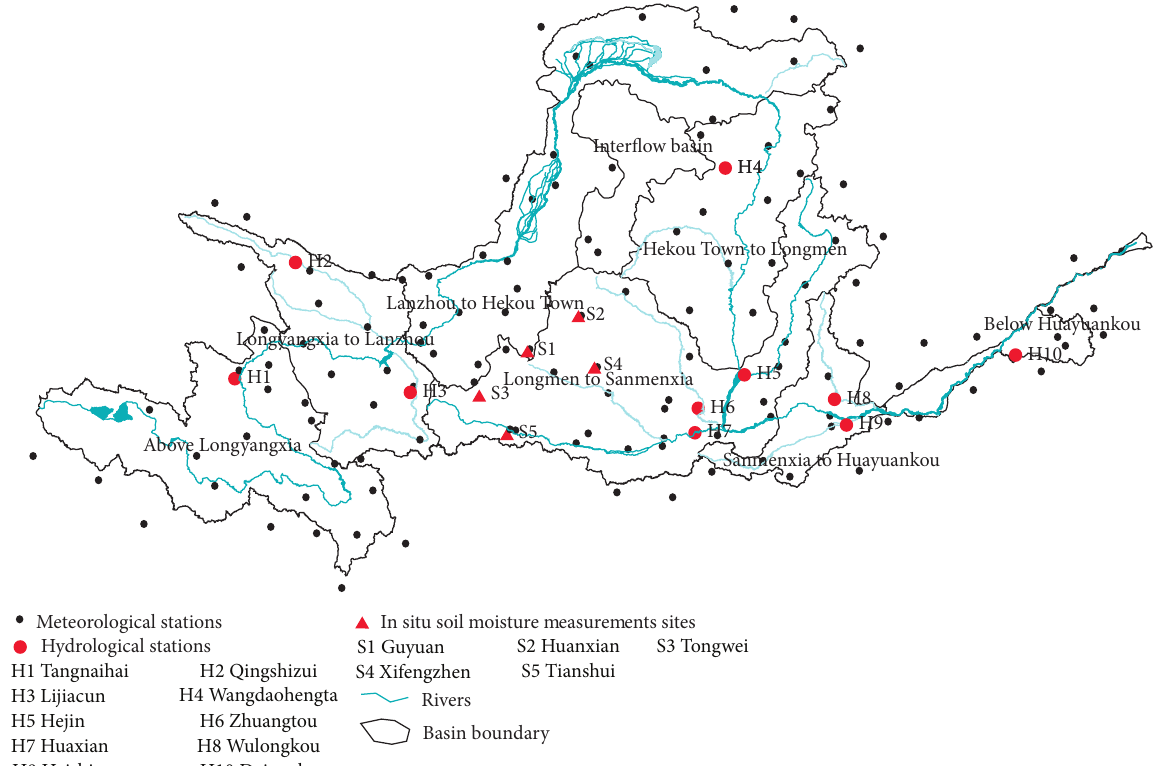
Figure 2: The geographic distribution of the 10 subbasins in the